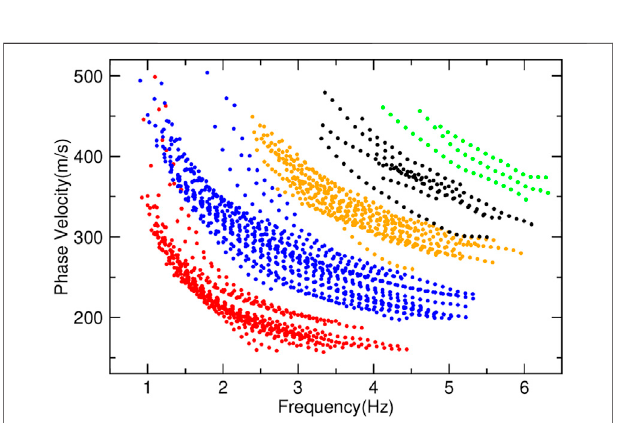
FIGURE7| AlldispersioncurvesextractedfromstackedVSs(SVS)ofall OBS stations along the pro fi le. The red, blue, orange, black, and green dots denote the fundamental to fourth higher-order mode,